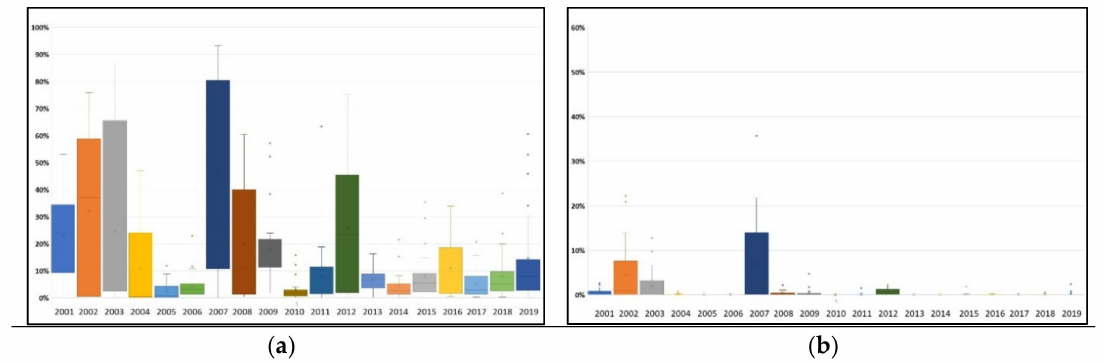
Figure 10. Box-plot type diagram of agriculture areas a ff ected: ( a ) by drought with di ff erent intensities; ( b ) by extreme drought, between 2001 and 2019 in Baragan Plain. The number of samples for 2001 is 21 and for the other years it is